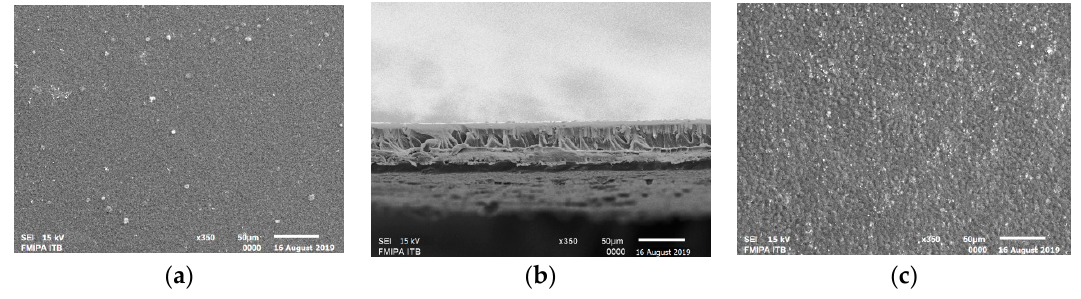
Figure 1. SEM Images (350× magnification) of the structure and morphology of the cross-linked chitosan/starch membranes made with a composition of 3% chitosan, 1.5% D. hispida starch, 5.6 × 10 − 5 mol glutaraldehyde, and 0.4% glycerol. ( a ) Top layer, ( b ) Cross-section, and ( c ) Bottom layer.